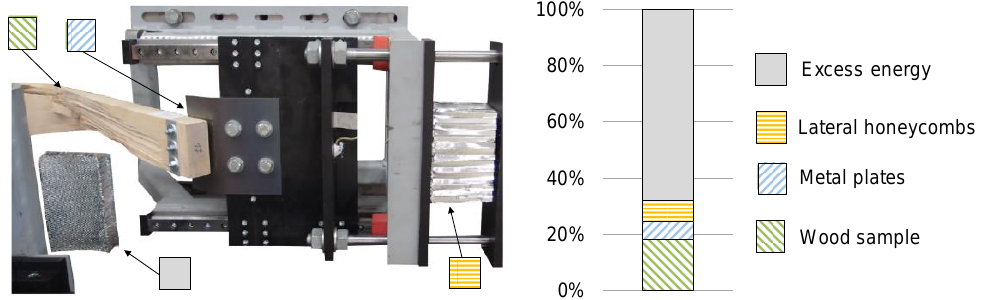
Figure 7. Schematic distribution between the energy absorbing elements in the test bench of the dynamic tests.